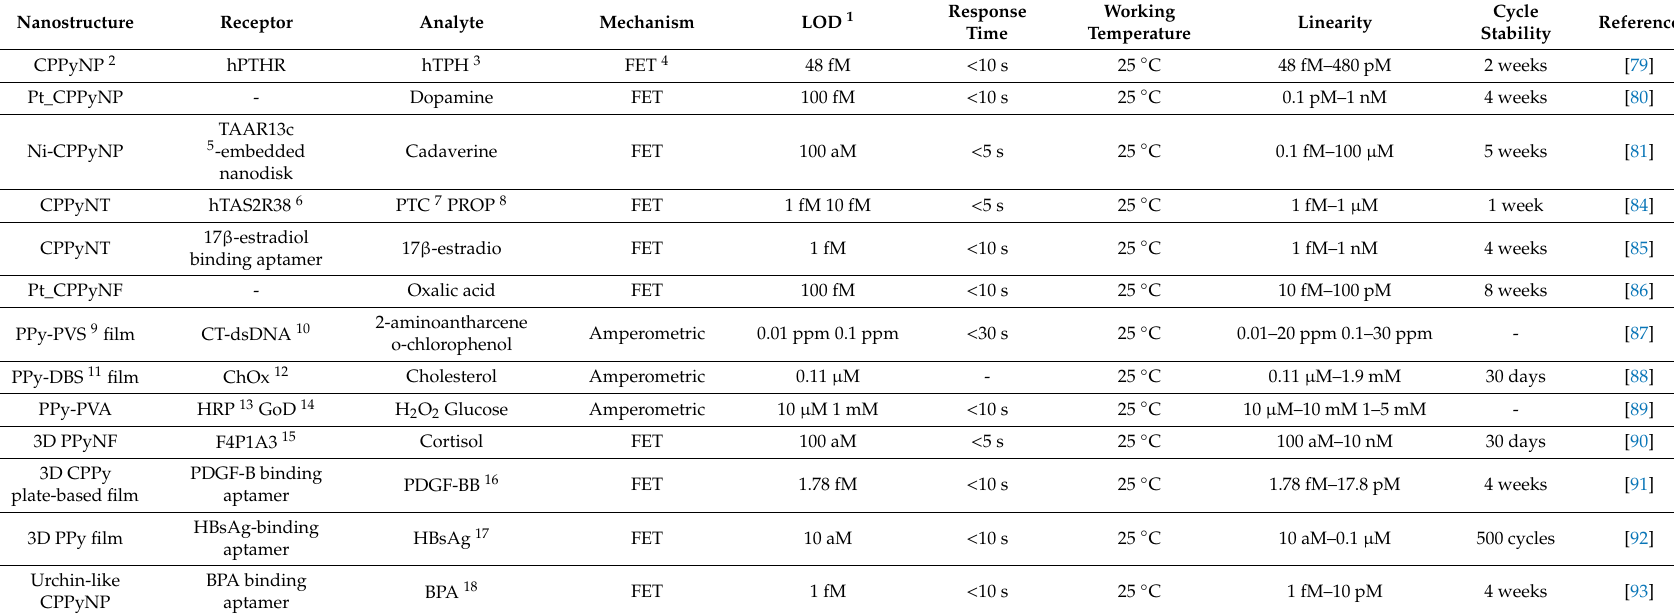
Table 1. Comparative sensing performance and limit of detection of polypyrrole nanostructure-based